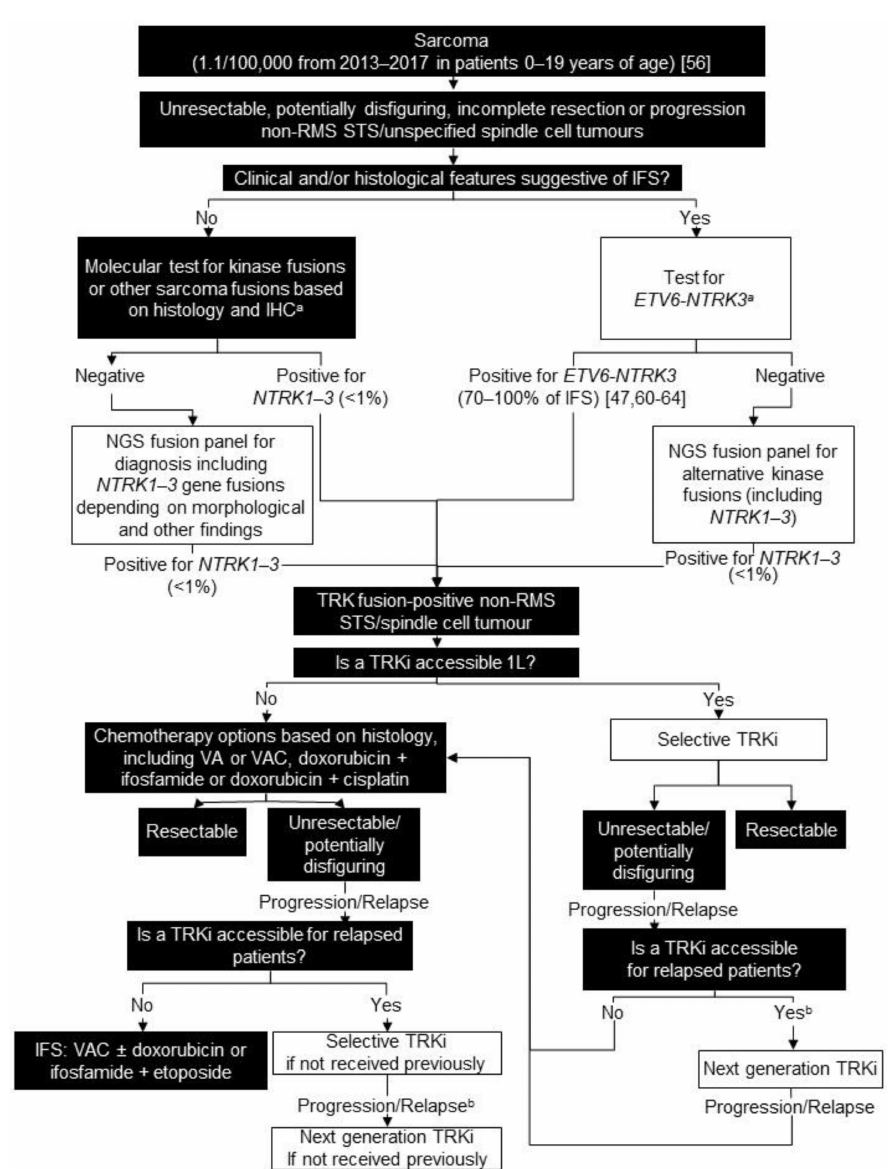
Figure 1. Biomarker testing and treatment for neurotrophic tyrosine receptor kinase ( NTRK ) gene fusions in sarcoma. White boxes with black outlines represent either NTRK gene fusion testing or treatment with a TRKi. Black boxes with white text indicate all other steps that do not include either NTRK gene fusion testing or treatment with a TRKi. a At discretion of lab; b Consider re-biopsy and molecular test to confirm acquired resistance mutation. ETV6 = ETS variant transcription factor 6; IFS = infantile fibrosarcoma; IHC = immunohistochemistry; L = line; NGS = next generation sequencing; RMS = rhabdomyosarcoma; STS = soft tissue sarcoma; TRK = tyrosine receptor kinase; TRKi = TRK inhibitor; VA = vincristine and adriamycin; VAC = vincristine, adriamycin, and cyclophosphamide. Knezevich et al. 1998 [47]; National Cancer Institute [56]; Knezevich et al. 1998 [60]; Bourgeois et al. 2000 [61]; Rubin et al. 1998 [62]; Sheng et al. 2001 [63]; Loh et al. 2002